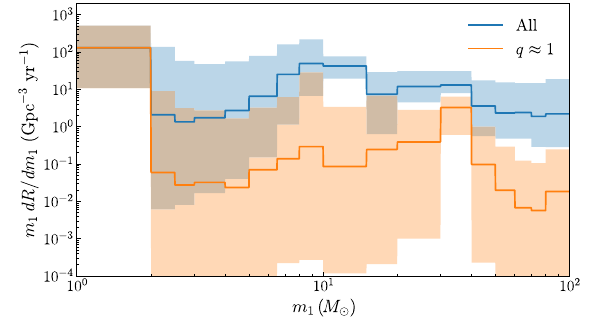
FIG. 4. Impact of asymmetric binaries on the primary mass distribution, illustrating how the depth and extent of a mass gap in anyone-dimensionaldistributiondependsonthechoiceofslicingor marginalization over the remaining dimension. Differential merger rate as a function of primary mass for the BGP model when considering only the diagonal q ≃ 1 bins in Fig. 3, i.e., m 1 dN= dm 1 dqdV dt j and the population of compact binaries across all c q ≃ 1 mass bins. The rate for approximately equal-mass binaries is significantly lower highlighting the contribution of asymmetric mergerslikeNSBHs tothemarginaldistributionoverprimarymass. The plot uses the BGP population model inferred from events passing a FAR threshold of < 0 . 25 yr − 1 . Solid curves represent